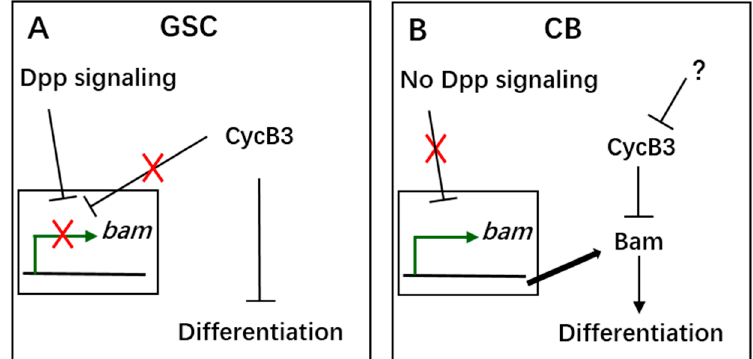
Figure 8. Model to explain how cycB3 regulates GSC self-renewal and CB differentiation. ( A ) cycB3 is required for GSC maintenance, because it represses GSC differentiation; ( B ) Bam is necessary for CB differentiation and cycB3 function is positioned upstream of Bam action in CBs.